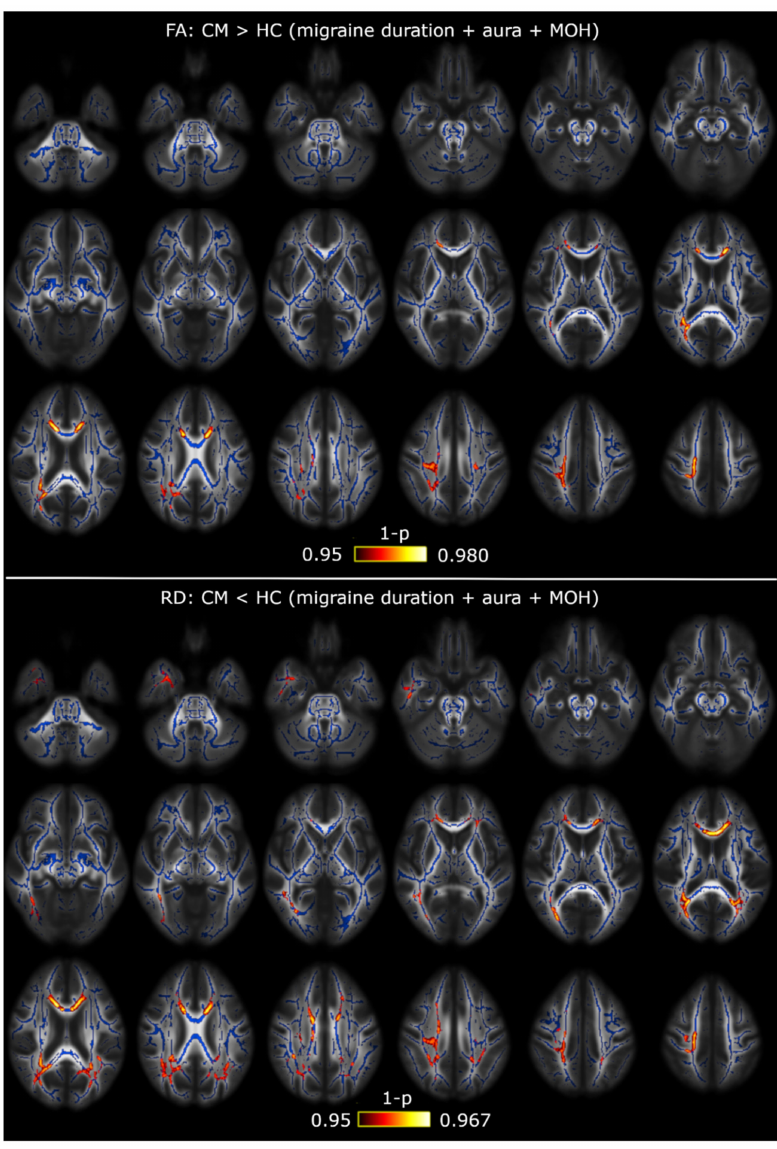
Figure A7. FA and RD alterations between CM and HC including duration of the migraine, presence of aura and medication overuse headache as covariates. TBSS showed increased FA and decreased RD values in CM with respect to HC. The white matter skeleton is shown in blue, and voxels with the lowest p -values in red-yellow. The color bar shows the 1-p-values (FWE-corrected). MOH = medication overuse